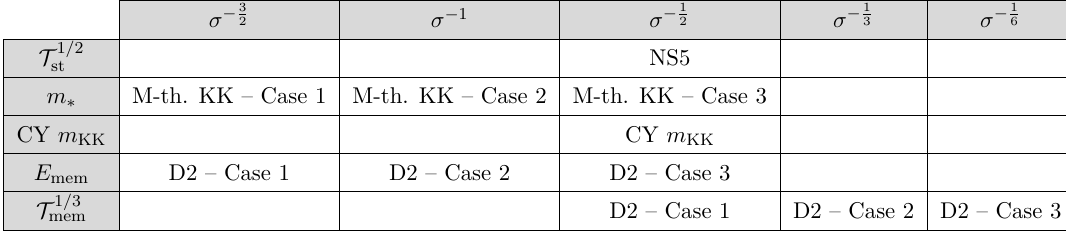
Table 4 . Mass scalings along the flows generated by NS5-strings in IIA orientifold